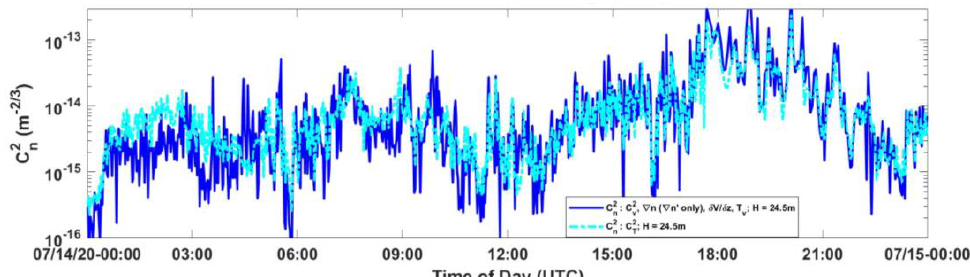
Figure 5. Profiles of C n2 at 24.5 m above the surface using in situ sonic anemometer measurements derived from (a.) 𝐶 𝑣2 at 24.5 m, as well as ∇𝑛 ′ (large scale index of refraction gradient removed), and 𝜕𝑽 𝜕𝑧 ⁄ derived on sonic anemometer measurements at both 24.5 m and 10.2 m; and (b.) derived from C T2 calculated using the in situ point measurement of the sonic temperature, 𝑇 𝑠 , at 24.5 m. A 90-second ensemble averaging time is used for the plots.